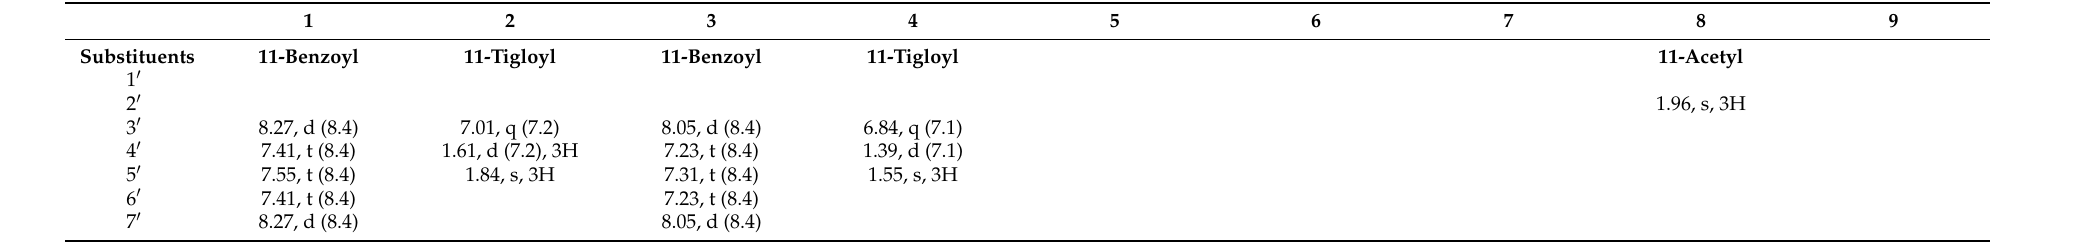
Table 2. 1 H NMR Spectroscopic Data of the Decorating Groups of Compounds 1 – 9 in Pyridine- d 5 (600 MHz, J in